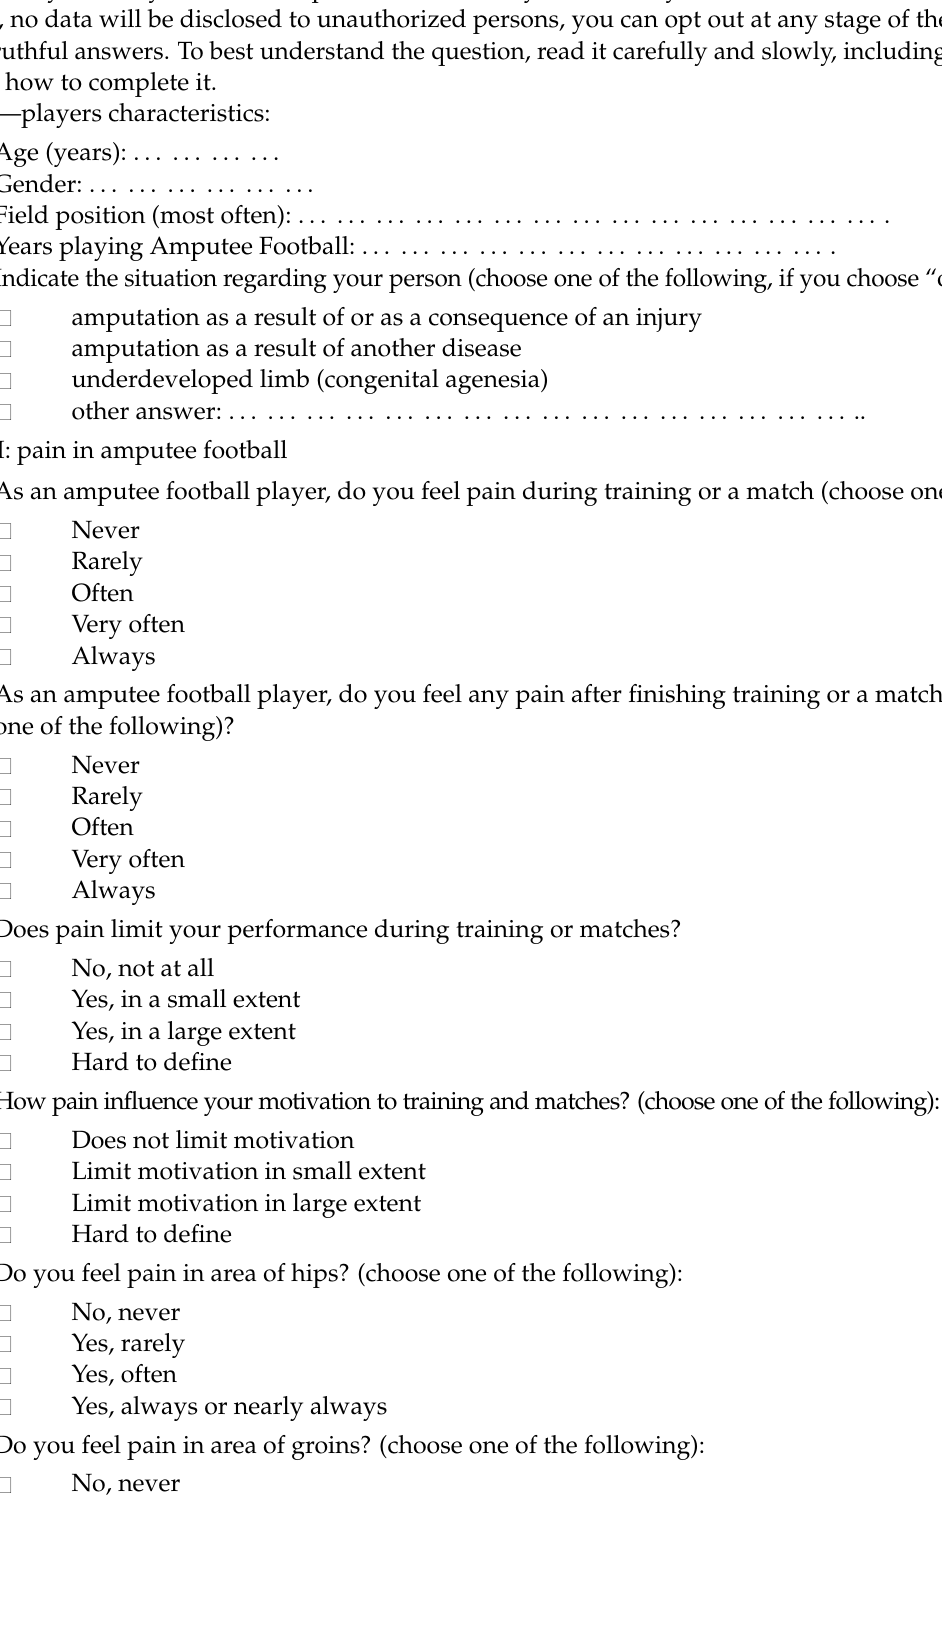
Appl. Sci. 2022 , 12 , 6978